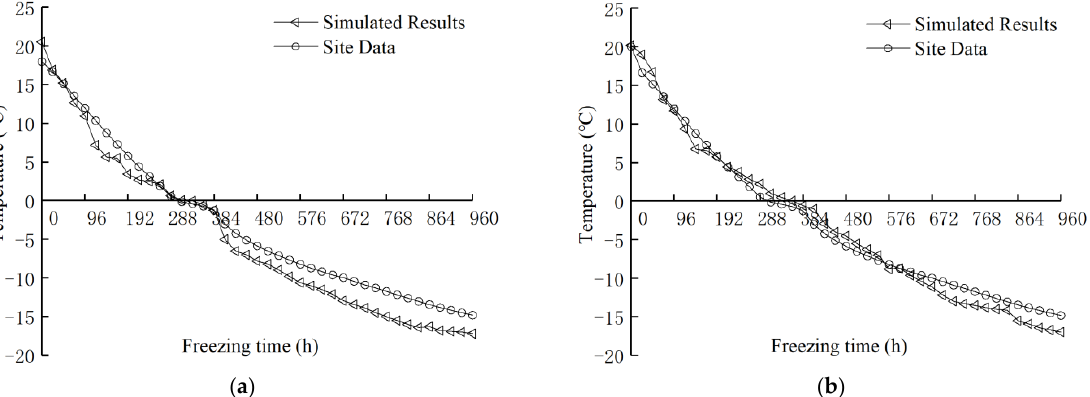
Figure 5. Comparison between simulated results and site data. ( a ) Measuring point 1, ( b ) measuring point 2.